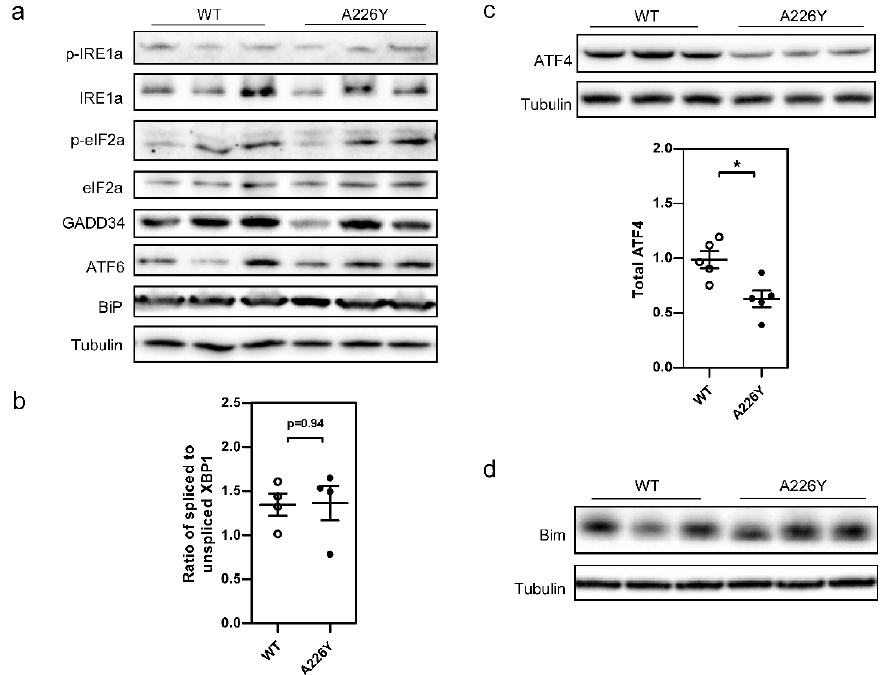
Figure 1. Absence of UPR and ISR activation in the liver of mistranslating A226Y mice. ( a ) Western blots showing total and specific phosphorylation levels for key players in the three branches of the ER-UPR. Significance level for comparison between A226Y and WT ( N = 5): p-IRE1 (Ser724)/IRE1a p = 0.43; p-eIF2a (Ser51)/eIF2a p = 0.55; GADD34 p = 0.77; ATF6 p = 0.48, BiP p = 0.64. Densitometry values were normalized to tubulin as the loading control. ( b ) qRT-PCR quantification of spliced XBP1 relative to un-spliced XBP1 ( N = 4, p = 0.94). ( c ) Western blot of total ATF4 protein normalized to tubulin ( N = 5, p = 0.01). ( d ) Western blot of total Bim protein normalized to tubulin ( N = 5, p = 0.45). Plots show mean, SEM, and individual data points. * p < 0.05, calculated by unpaired two-sided Student’s t -test. N = number of independent mice in each comparison. Full gel images are provided in the Supplementary Materials.